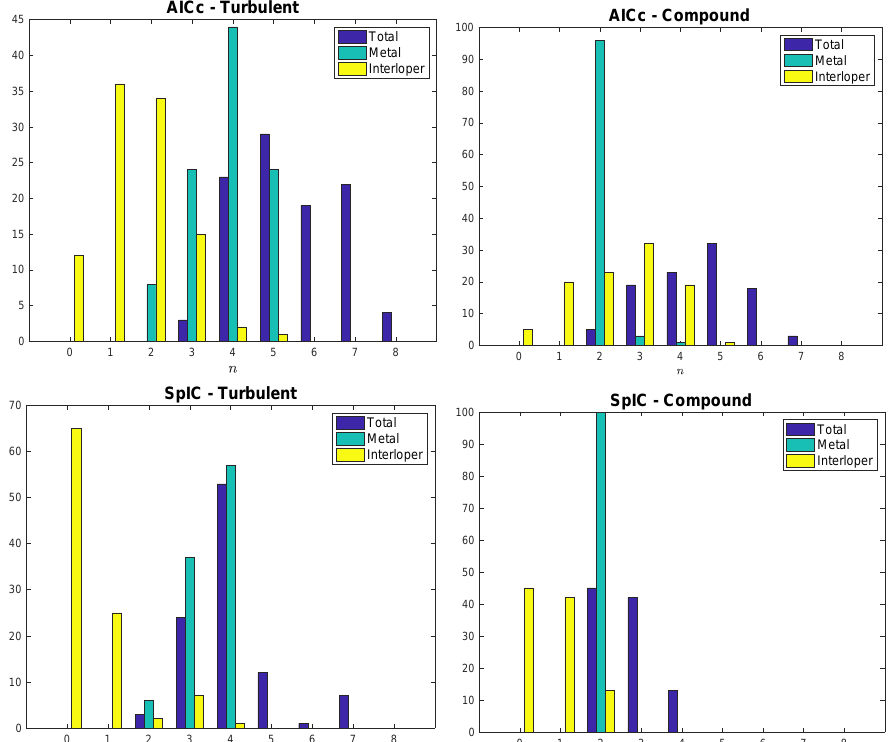
Figure 5. Number of absorption components for the results illustrated in Figure 4. The spectrum being modelled comprised 2 components. Top left : AICc/turbulent results in severely over-fitted data (light blue). Lower left : SpIC/turbulent also over-fits the data but not quite as severely as AICc/turbulent. The turbulent model results have been obtained using distortion blinding, as de- scribed in Section 4.2. Top right : AICc/compound produces very slight over-fitting. Lower right : SpIC/compound produces no over-fitting. Distortion blinding has not been used for the compound model results. The yellow bars indicate additional interloper (i.e., components not identified as heavy element) components automatically included in the fits by AI - VPFIT . These are purely a consequence of chance noise correlations in the input spectrum and appear to have no impact on the final value of ∆ α / α